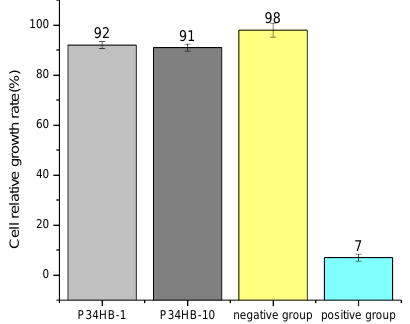
Figure 7. Cell relative growth rates for P34HB-1 and P34HB-10.